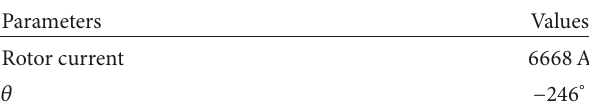
Table 2: Iteration result of stator and rotor currents.